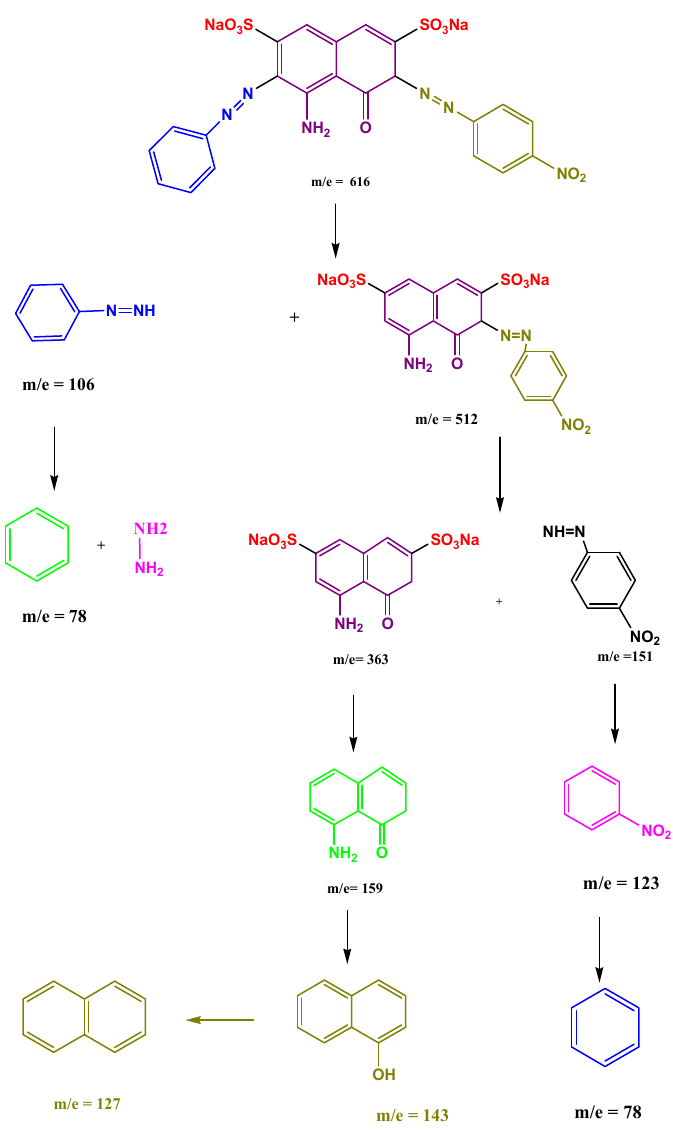
Fig. 10. Degradation mechanism of Nigrosine